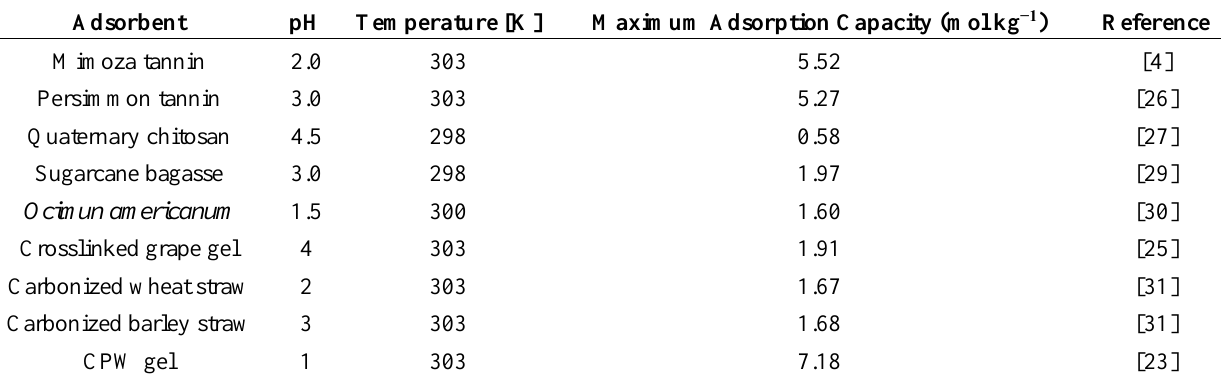
Table 2. The maximum adsorption capacity for chromium ion(VI) for different adsorbents.